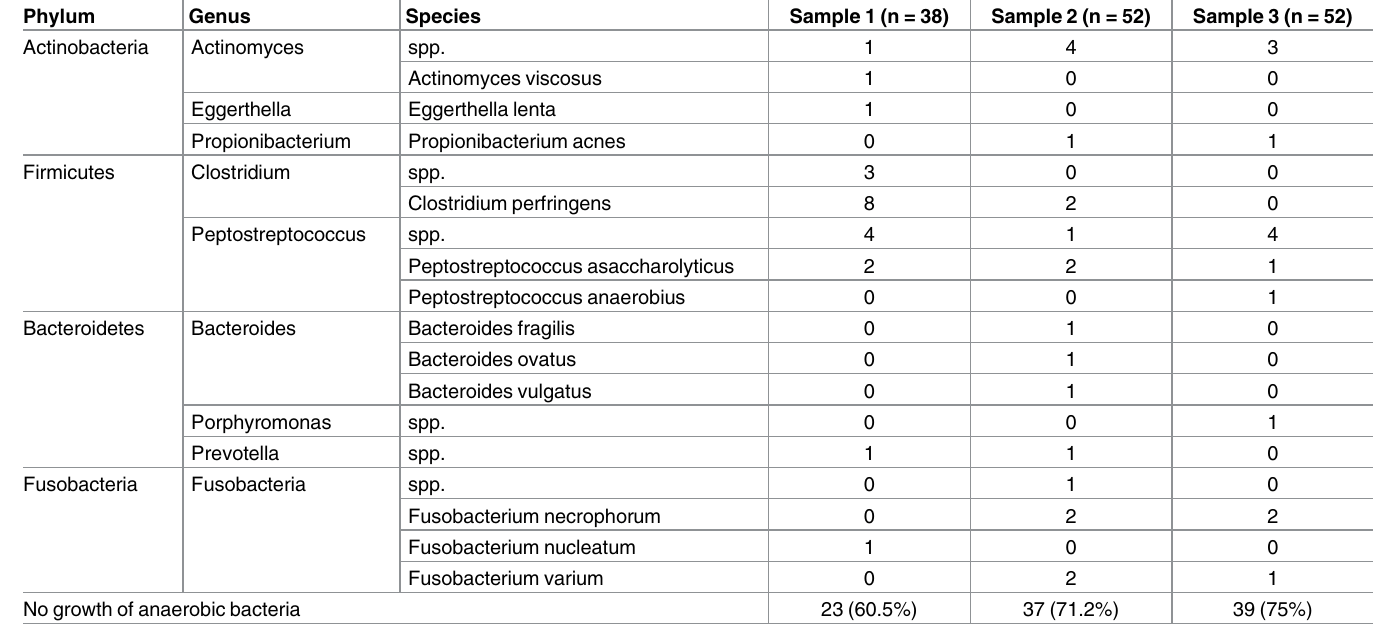
Table 2. Number of samples that cultured positive for each type of anaerobic bacterial species isolated from uterine samples on the day of calving (sample 1), the day of follicle fluid aspiration ± 1 (sample 2), and on 35 ± 1 days postpartum (sample 3). Phylum